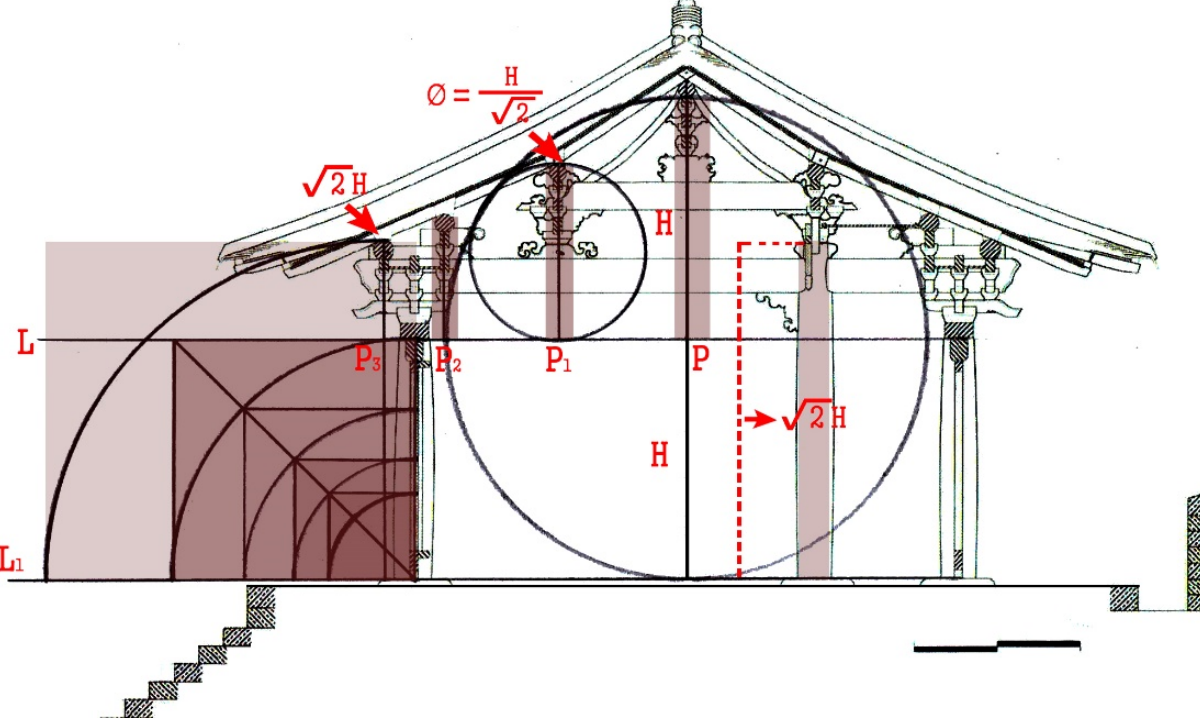
Figure 13. Eungjinjeon Hall of Seongbulsa Monastery. Proportional analysis of the sectional elevation (H = eave column height, Ø = circle diameter), Adapted from CHA (NRICH 1998, p. 42).